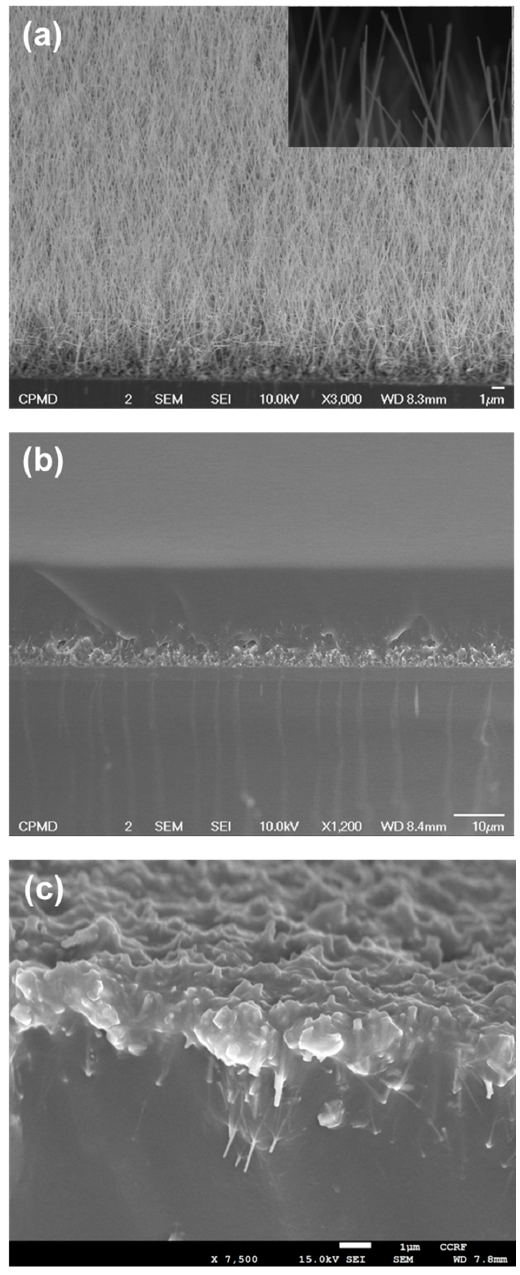
Figure 2. Scanning electron micrographs ( a ) vertical GaN NW on GaN thin film, inset shows the high magnification micrograph; ( b ) after deposition of PDMS on GaN NWs; and, ( c ) peeled-off PDMS matrix embedded with GaN NWs, bottom side of NWs is exposed while tope side is covered with